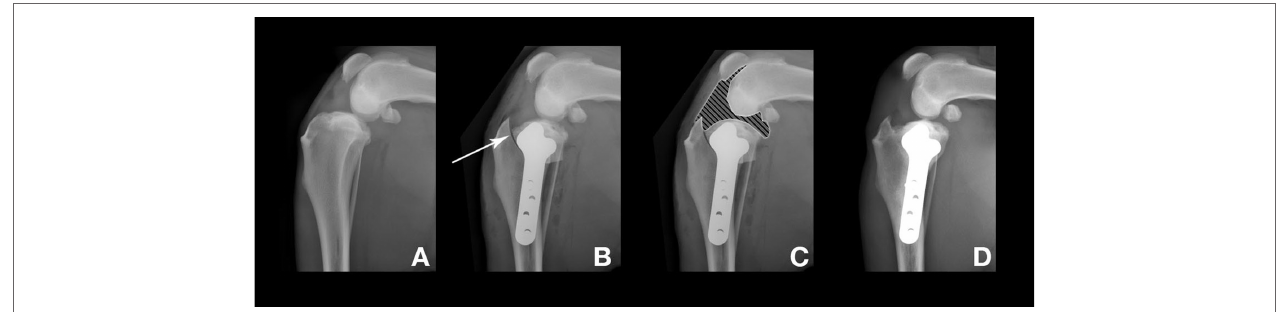
FiGUrE 4 | Radiographs before and after the tibial plateau leveling osteotomy surgery. The dog presented here was in the “mesenchymal stromal cell” group. (a) Preoperative stifle joint. (B) 1 day after surgery. Arrow: osteotomy line. (C) 1 day after surgery. Hatched area: articular zone. Note the direct contact with the osteotomy line. (D) M3 after surgery, complete bone healing and